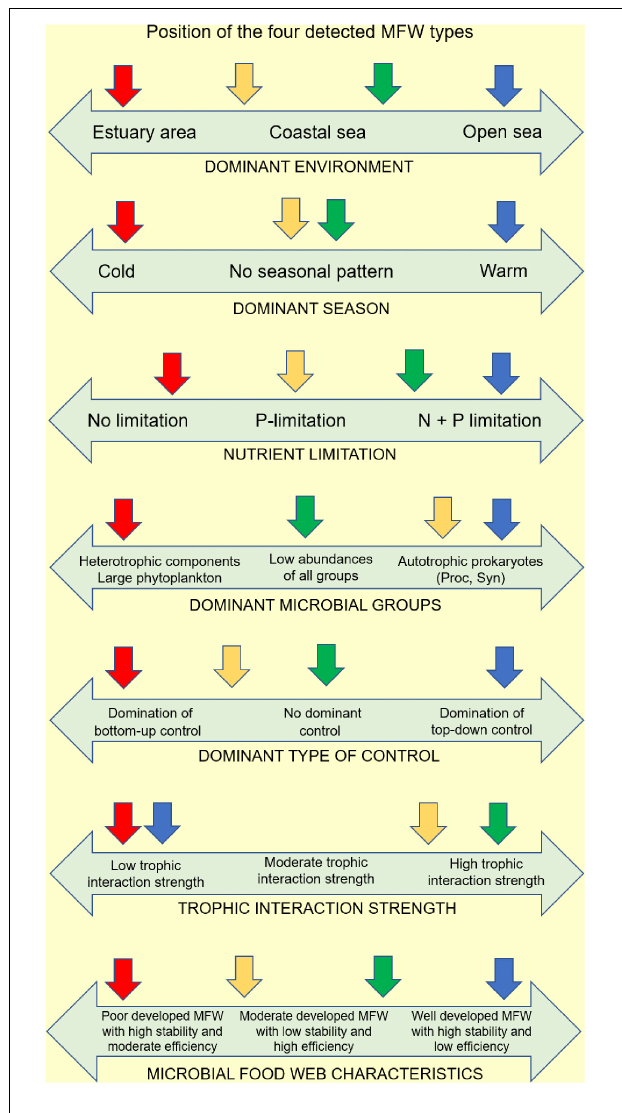
FIGURE 9 | Schematic representation of the features of the four types of MFW and the prevailing environmental conditions in which they develop (CL 1, blue arrow; CL 2, green arrow; CL 3, yellow arrow; CL 4, red